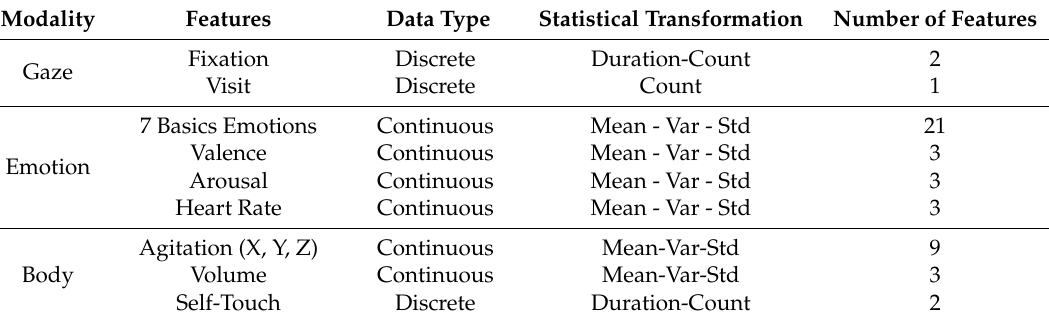
Table 3. Features of interest